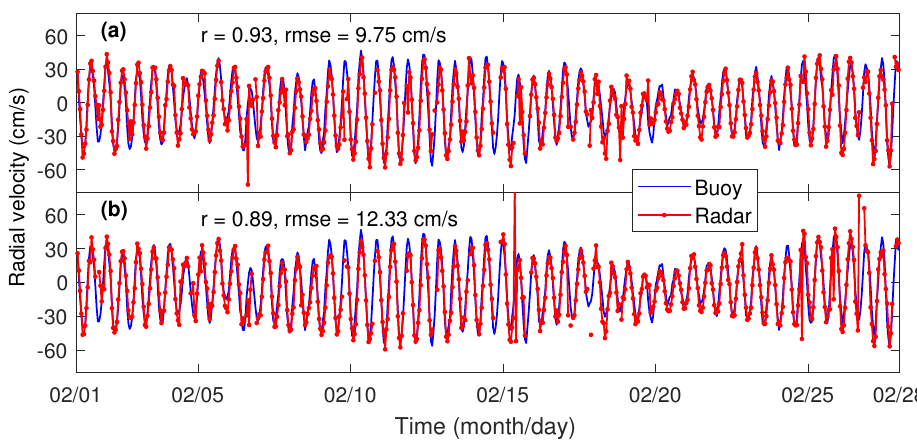
Figure 14. As in Figure 12, but for SHLI at buoy B. ( a ) the value of the constant number is equal to 0.2 ( µ = 0.2); ( b ) the value of the constant number is equal to 20 ( µ = 20).